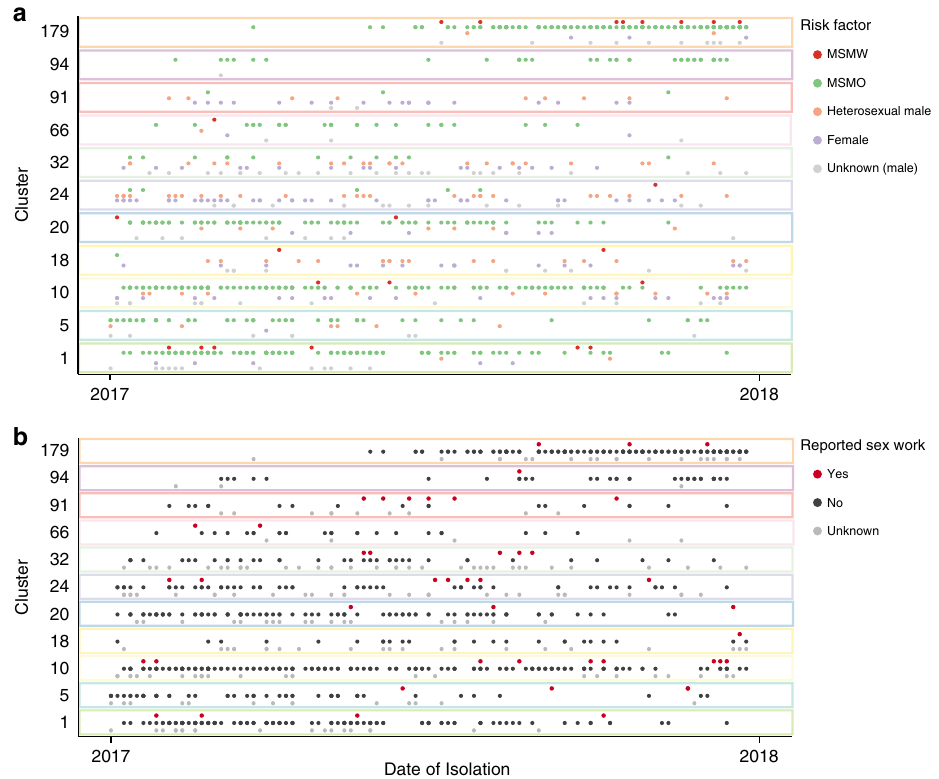
Fig. 4 Timeline of Neisseria gonorrhoeae isolates from the 11 major clusters. The fi gure is strati fi ed by a reported sexual behaviour and b reported sex work. The x -axis represents time, and each dot within the plots represents a single isolate. Data points are coloured by risk factor. Abbreviations : MSMO men who have sex with men only, MSMW men who have sex with men and